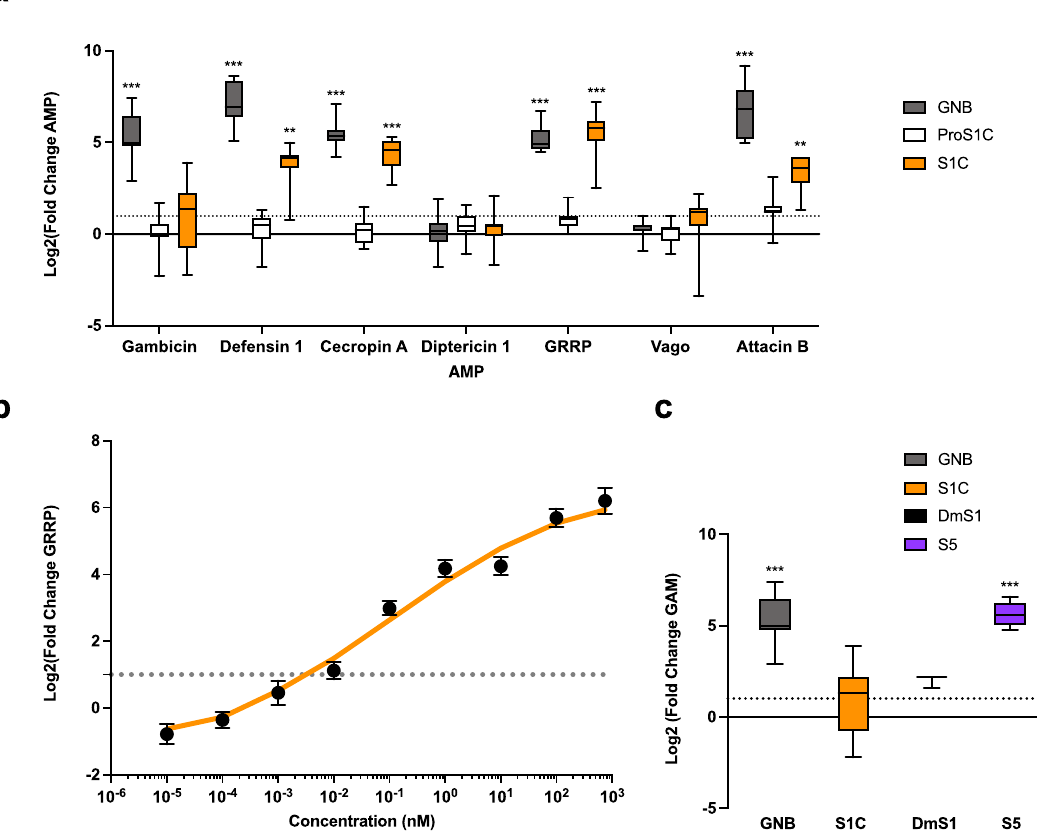
Fig. 5 | Cleaved but not proprotein Spaetzle1C activates antimicrobial peptide production. Spz1C activates a set of antimicrobial peptides ( a ), over a large range of concentrations ( b ), and in an isoform-speci fi c manner ( c ). Expression of anti- microbial peptides in Aag2 cells at 12hours after stimulation with heat-inactivated extractfrom Gram-negative bacteria (abbreviated GNB)or Spz1C (proS1C and S1C: before and after cleavage of the pro-domain, respectively) upon addition of pur- i fi ed protein at 100nM in the media and RT-qPCR. Data are presented as box plot with whiskers min to max values. ( n =12 biologically independent experiments – Except “ Vago ” condition where n =9) ( b ) Kinetics curves of GRRP expression in Aag2 cells after stimulation with different concentration of Spz1C (S1C). The fi tted curve (in orange) represents smoothed conditional means calcu- lated by ggPlot2 on R. Data are mean±SEM. ( n =18 to 36 biologically independent experiments for each concentration). c Differences in Gambicin (Gam) expression upon Spz1C, Drosophila melanogaster Spz1 (DmS1), and Aedes aegypti Spz5 (S5)